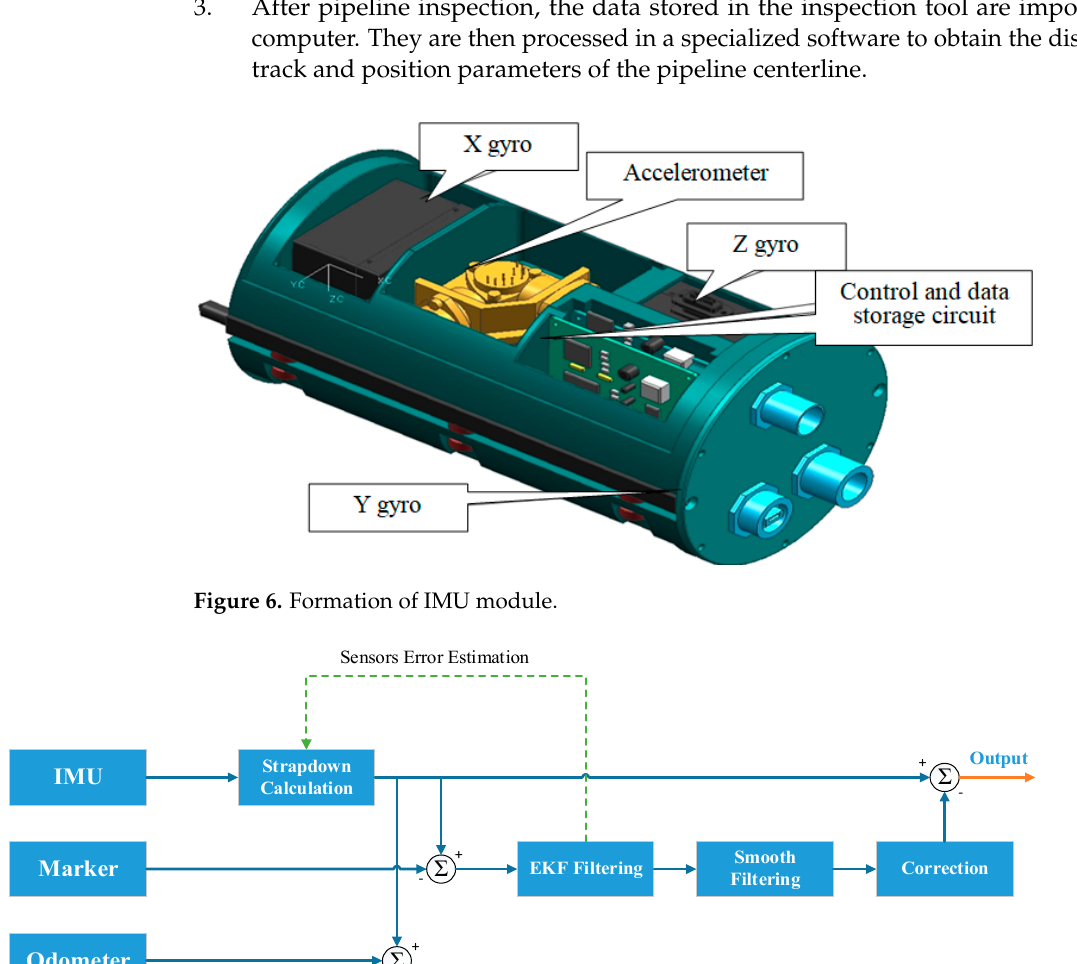
Figure 7. Multi-sensor data fusion of IMU inspection system.